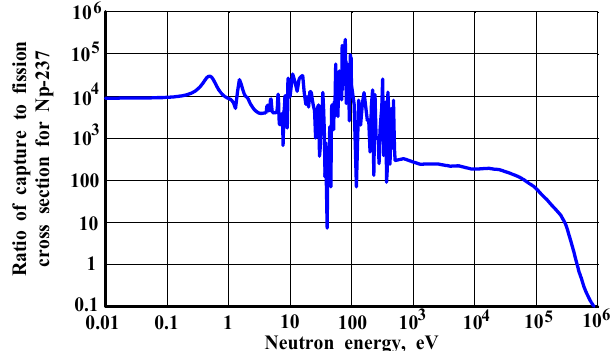
Figure 4. Ratio of capture to fission cross-sections for 237 Np.